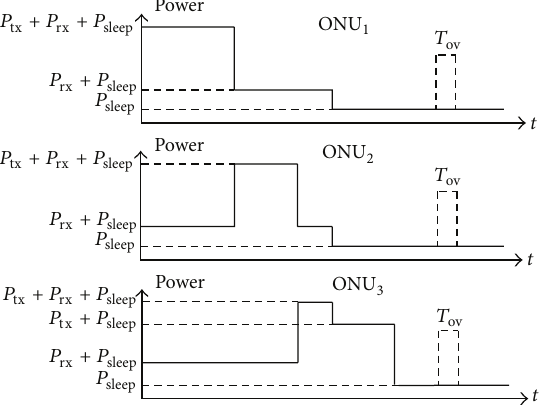
Figure 3: Power consumption of each ONU in Figure